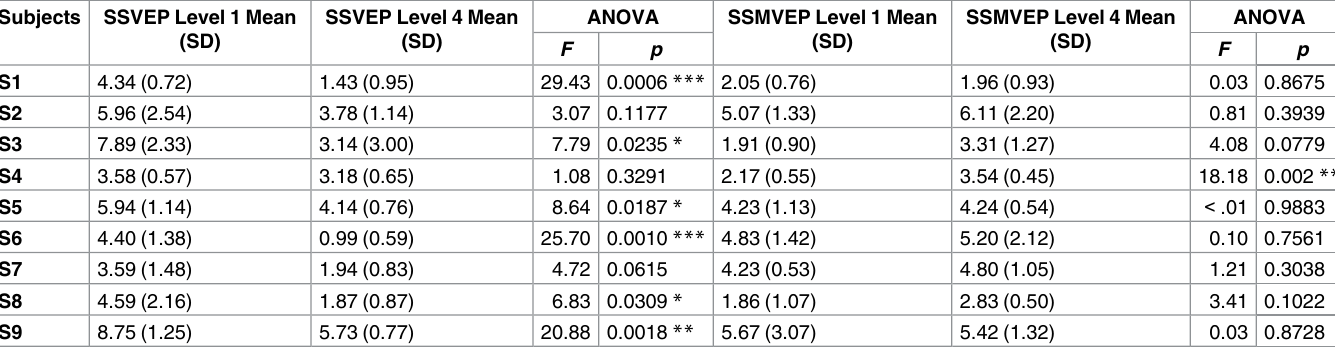
SNR variations under fatigue level 1 and 4 for individual subjects were listed in Table 2. Fig 6 presented the normalized power indices α , θ and θ + α for each of flickering SSVEP-BCI and motion-reversal SSMVEP-BCI conditions over nine subjects. The ongoing EEG has been proven to be closely related to changes in the level of fatigue in previous studies [13,29]. In the present study, the spectral powers of α , θ and θ + α over the first and last five Table 2. Statistical summary of the